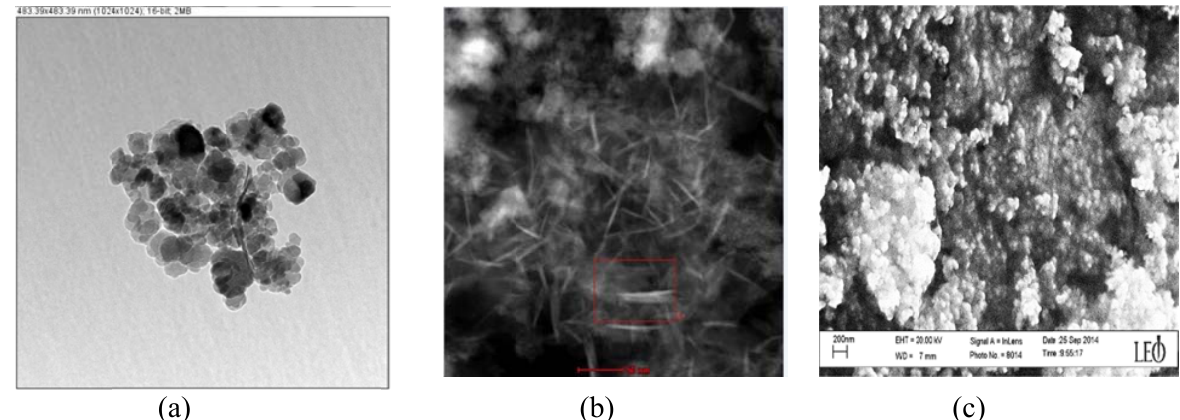
Fig.2: (a) TEM EM image at x=0.3 has lo orods. (c)SE EM image